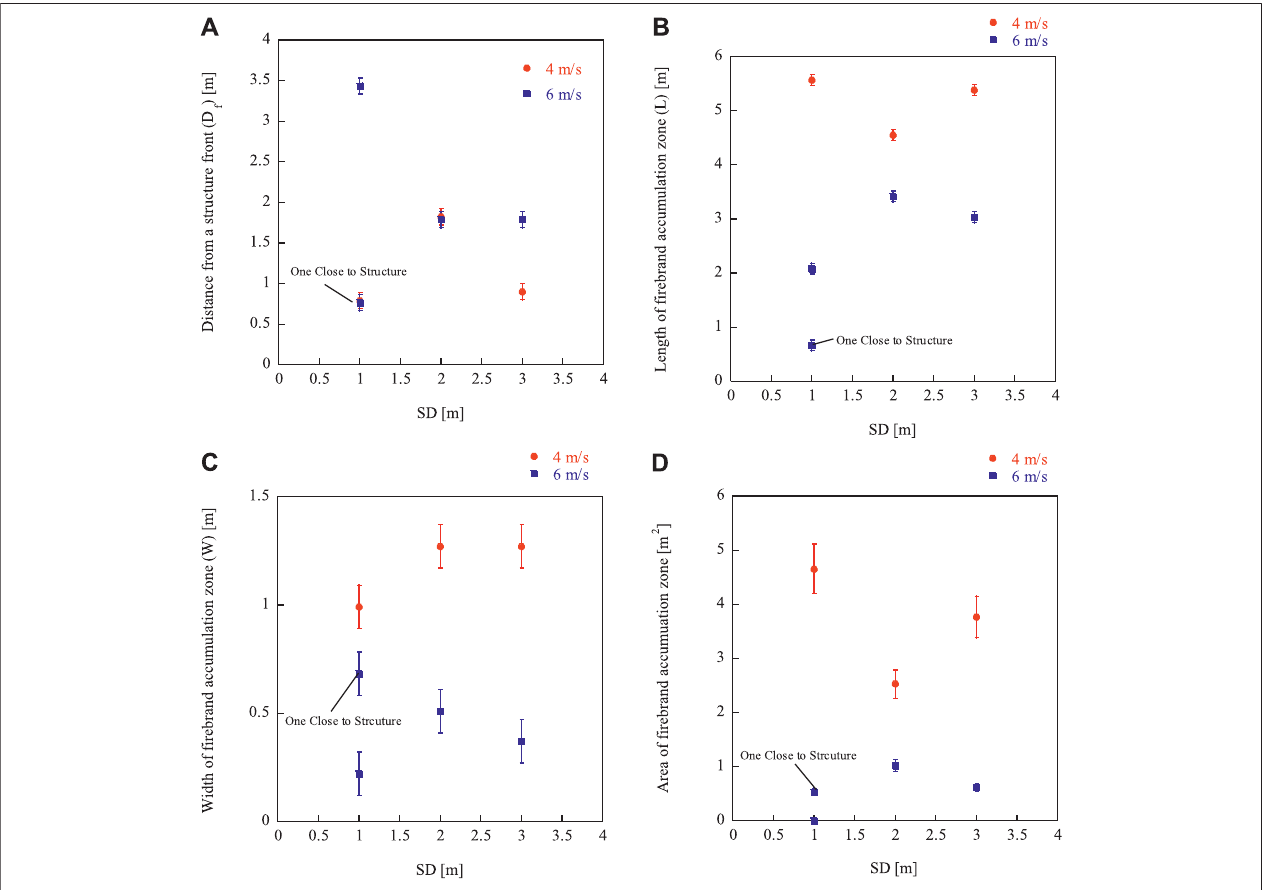
FIGURE 8 | Measurements of firebrand accumulation zone under 4 and 6 m s − 1 wind experiments (A) Distance from a structure front D f and SD (B) Length of fi rebrand accumulation zone (L) and SD (C) Width of fi rebrand accumulation zone (W) and SD (D) Area of fi rebrand accumulation zone and SD.